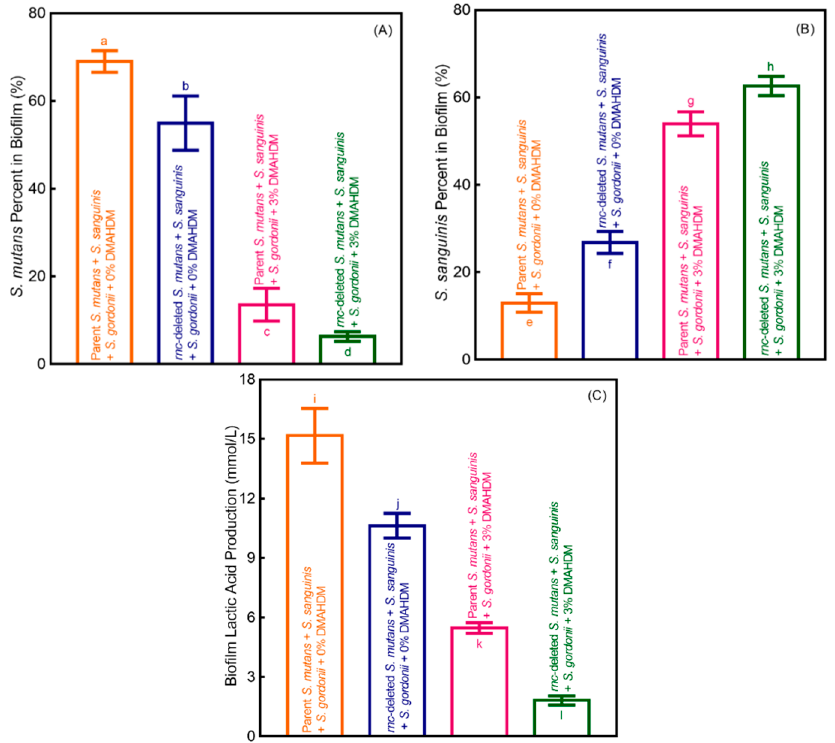
Figure 6. Effects of rnc -knockout alone, DMAHDM composite alone, the combination of rnc -knockout plus DMAHDM composite, on biofilm species shift and acid secretion. ( A ) Cariogenic S. mutans proportion, ( B ) noncariogenic S. sanguinis proportion , and ( C ) lactic acid secretion of Sm + Ss + Sg biofilm grown for 2 days on composites (mean ± SD; n = 6). In each plot, values with disparate letters (a, b, c, d, e, f, g, h, i, j, k, l) indicate data are significantly different ( p <